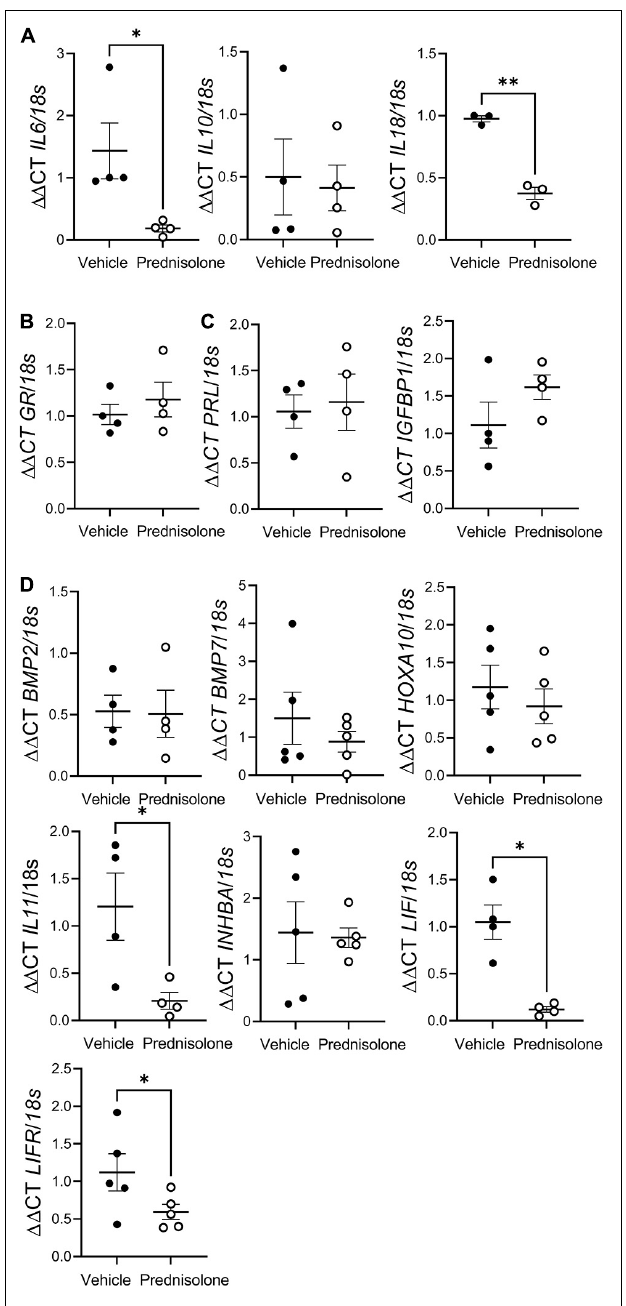
FIGURE 1 | Prednisolone suppressed pro-inflammatory cytokine production by human endometrial stromal fibroblast (hESF). Prednisolone treatment: (A) inhibited hESF pro-inflammatory cytokine [ interleukin (IL) 6 , and IL18 ] gene expression, but had no effect on IL10 gene expression, paired t -test, n = 3-4/group; (B) had no effect on hESF glucocorticoid receptor ( GR ) gene expression, paired t -test, n = 4/group; (C) had no effect on classic decidualization makers prolactin ( PRL ) or insulin-like growth factor binding protein (IGFBP)1 expression; (D) had no effect on decidualization genes bone morphogenic protein (BMP)2 , BMP7 , homeobox A (HOXA)10 or inhibin β A (INHBA) , but inhibited IL11 , leukemia inhibitory factor (LIF) and LIF receptor (LIFR) gene expression, paired t -test, n = 4/group. Data presented as mean ± SEM; *P < 0.05.